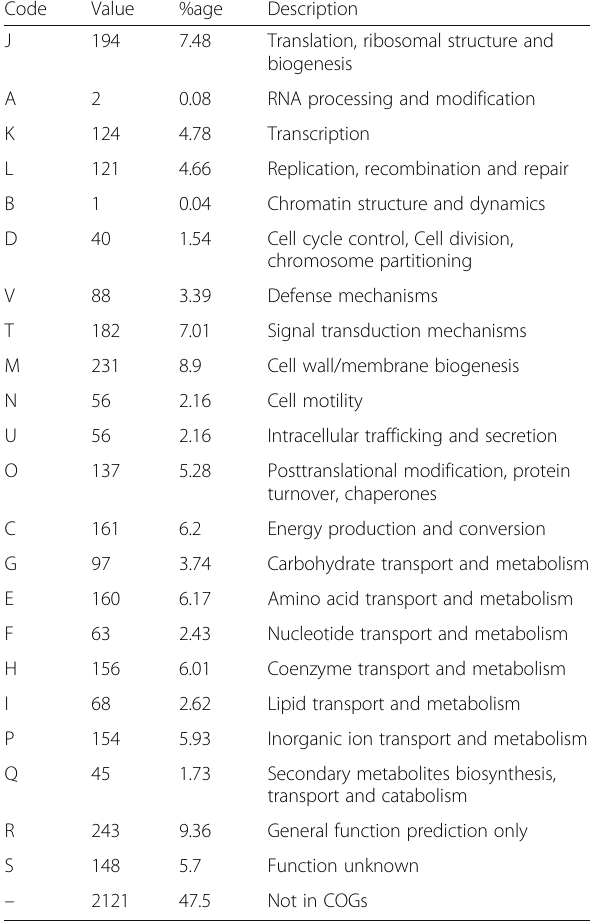
Table 4 Number of genes associated with general COG functional